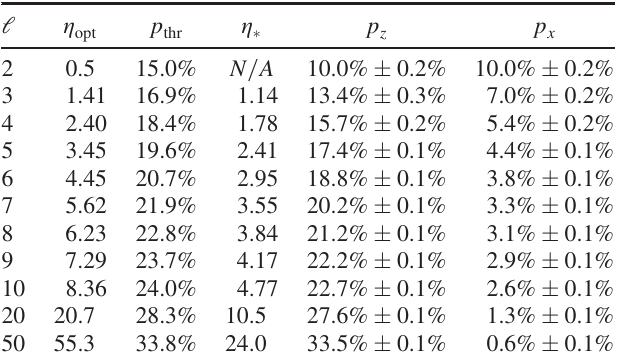
TABLE II. Thresholds for the union-find decoder in the code- capacity model. Simulations were done on lattices of size 81 × 81 at most.